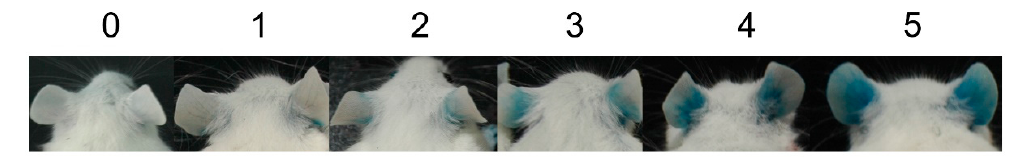
Figure 1. The scoring standard (from “0” to ”5”) for evaluating the areas of blue color in ear